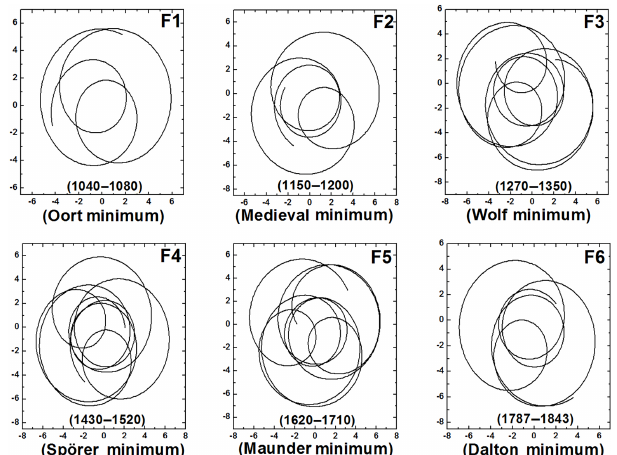
Figure 7. Characteristic diagram of the sunspot cycles.